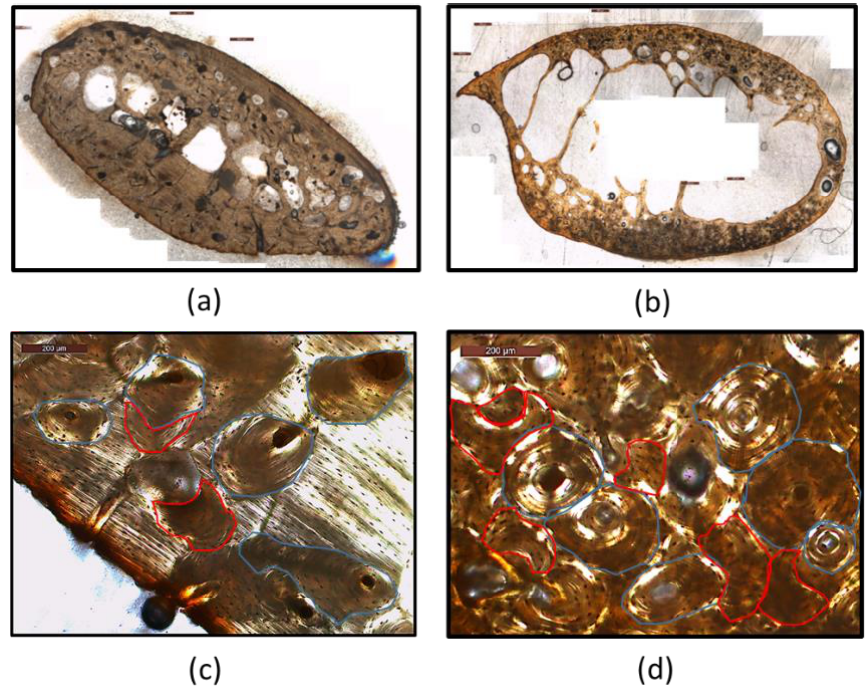
Figure 1. Age-related differences in the microstructure of cortical bone. Note the differences in cortical thickness and osteon density between rib 4 (1.5 years old) and rib 2 (69 years old). ( a ) Cross-section of rib 4; ( b ) cross-section of rib 2; ( c ) rib 4 and ( d ) rib 2 indicating examples of intact osteons (blue outline) and osteon fragments (red outline).